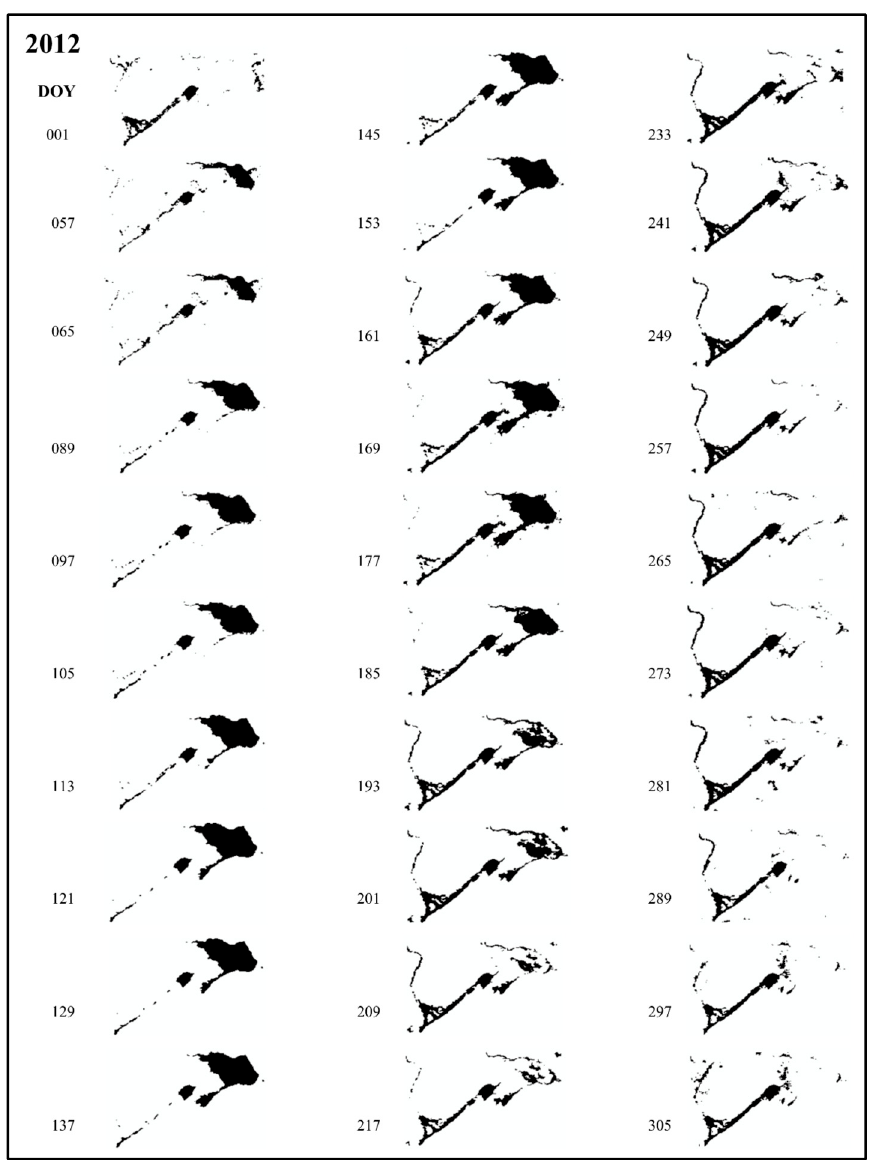
Figure 10. Time series of classified MODIS LST images showing the movement of surface flooding through the CRB in 2012.